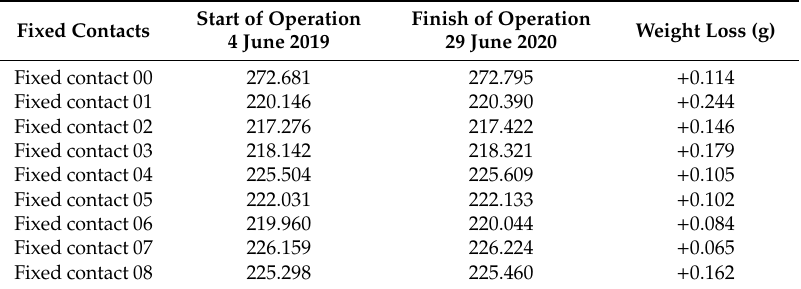
Table 8. Comparison of the masses of the voltage regulator fixed